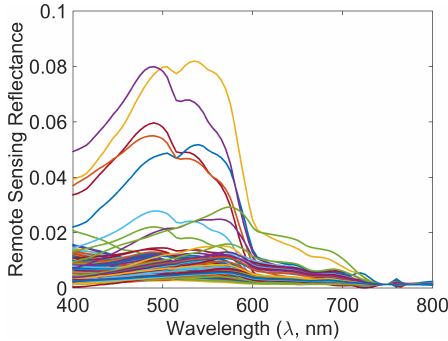
Figure 1. Spectral remote sensing reflectances (cid:126) R m in Dataset 1.